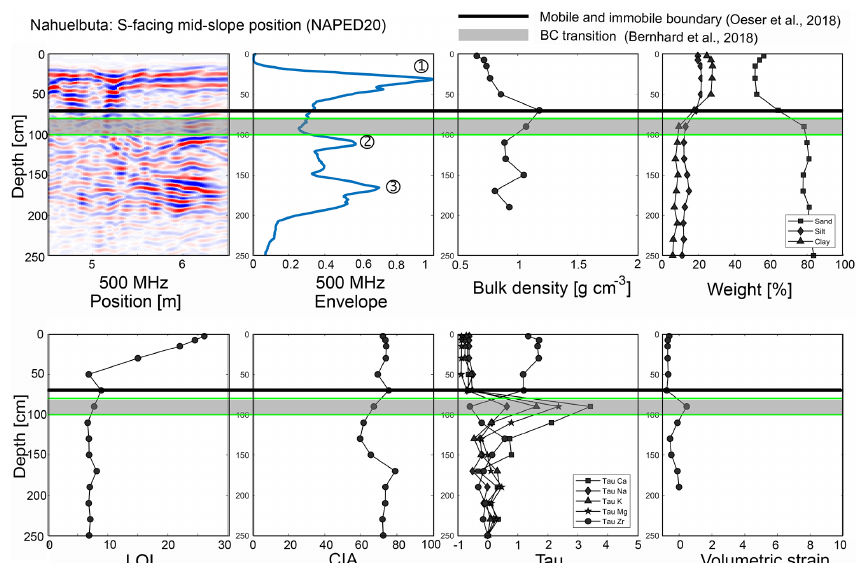
Figure 10. Compilation of physical and chemical investigations at the pedon location in the mid-slope position of the S-facing hillslope in Nahuelbuta. Properties shown are listed as in caption of Fig. 4. Note that only the 500MHz signal and envelope profile exist.